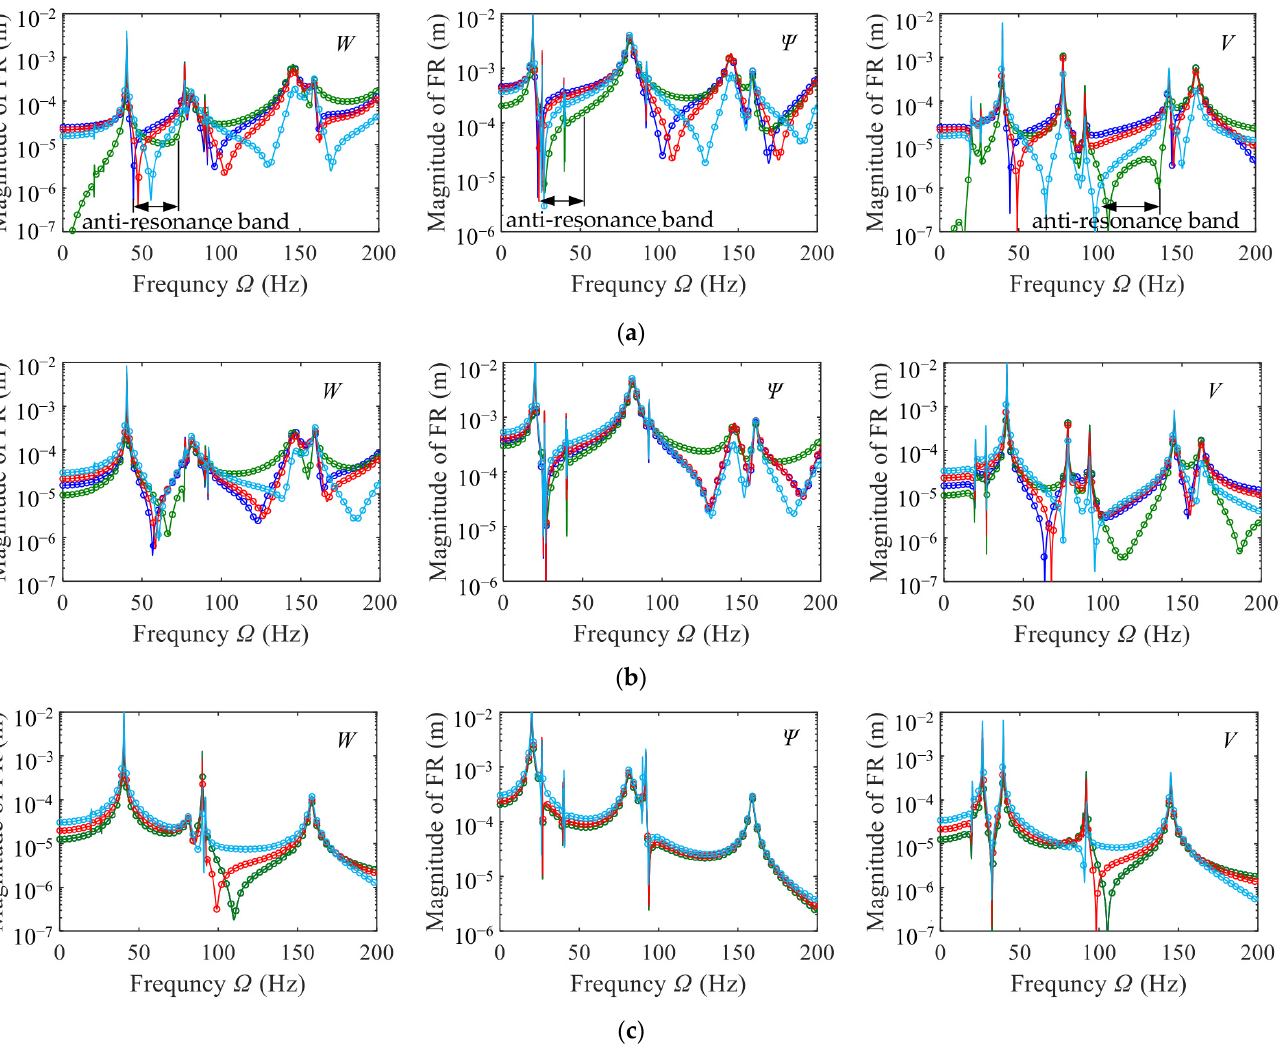
Figure 5. Frequency response at P 1 , P 2 , P 4 , and P 5 , as illustrated in Figure 4 ( FR at P 1 with the presented method, ○ FR at P 1 with FEM, FR at P 2 with the presented method, ○ FR at P 2 with FEM, FR at P 4 with the presented method, ○ FR at P 4 with FEM, FR at P 5 with the presented method, and ○ FR at P 5 with FEM). ( a ) Force is applied at P1; ( b ) Force is applied at P 2 ; ( c ) Force is applied at P 3 .